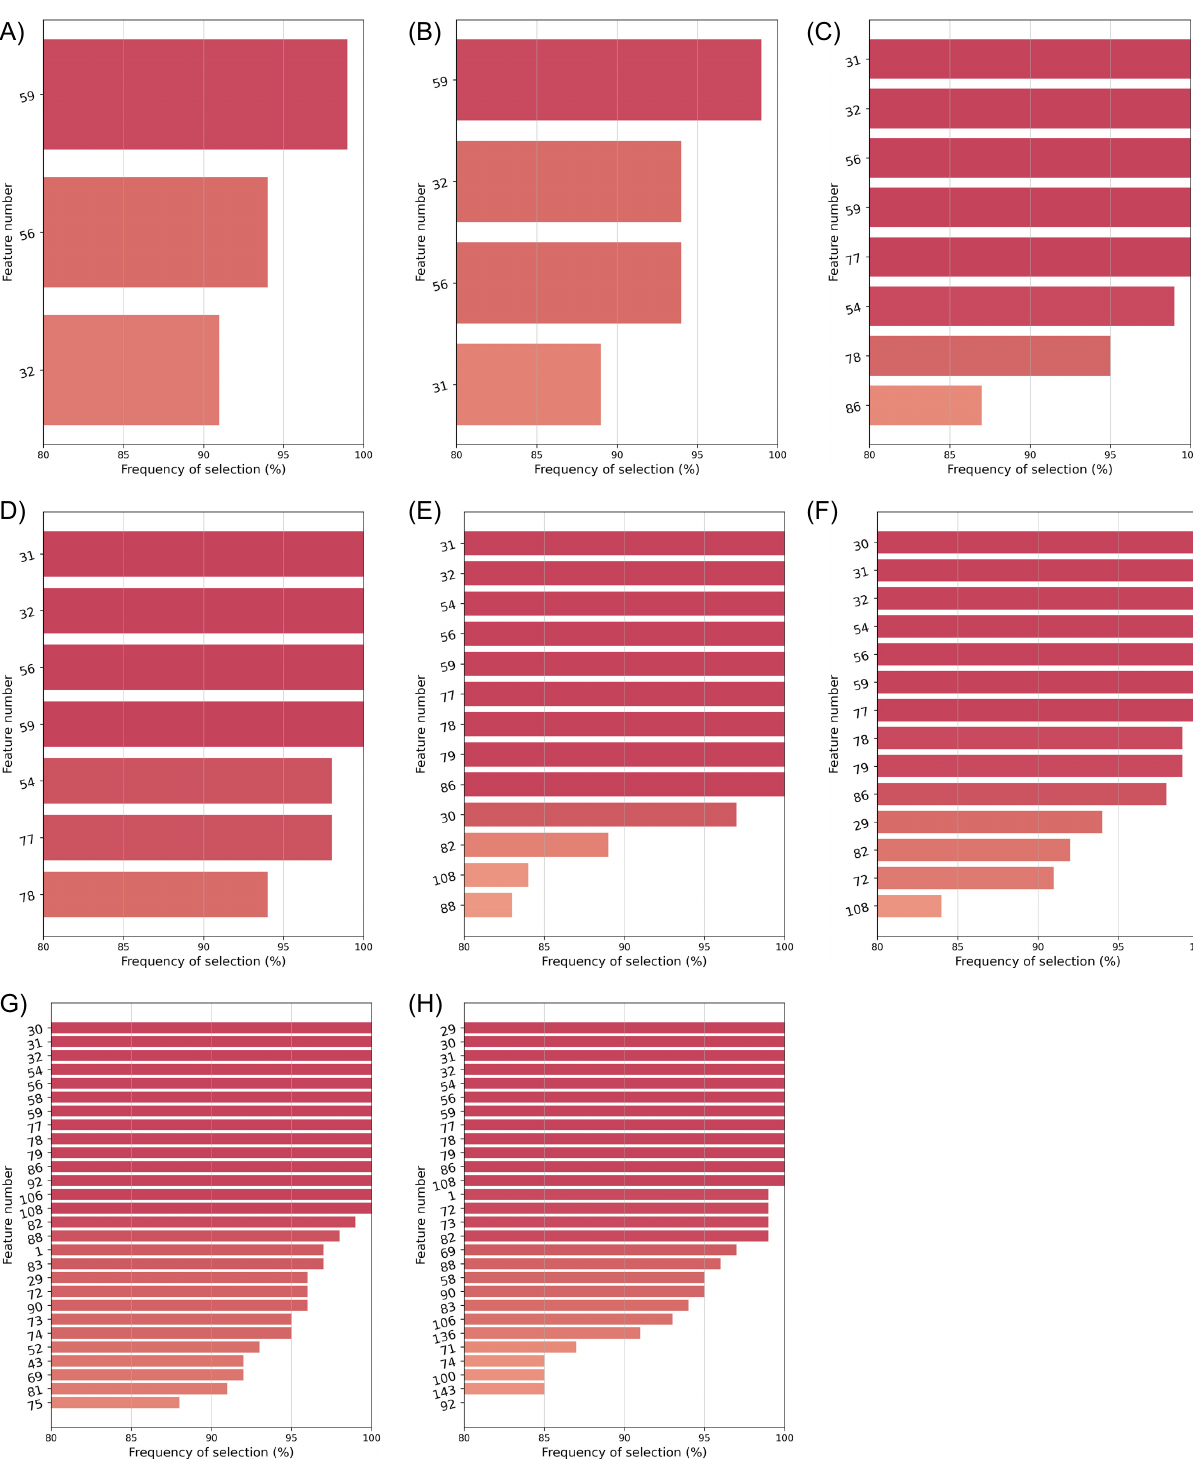
Fig 4. Features selected in ⩾ 80% cases by the stable RBA filters: All of them without imputation. ( a ) ReliefF ( k = 1 00): n FS = 5. ( b ) MultiSURF: n FS = 5. ( c ) ReliefF ( k = 100): n FS = 10. ( d ) MultiSURF: n FS = 10. ( e ) ReliefF ( k = 100): n FS = 20. ( f ) MultiSURF; n FS = 20. ( g ) ReliefF ( k = 100): n FS = 40. ( h ) MultiSURF: n = FS